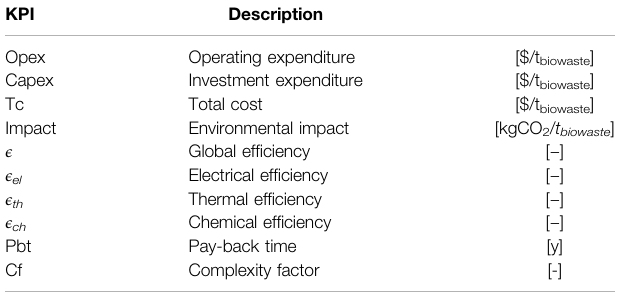
TABLE 1 | Key performance